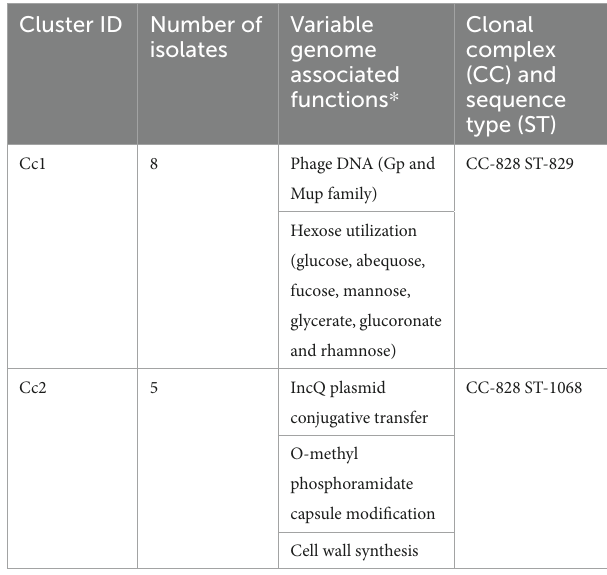
TABLE 5 Variable genome clusters in Campylobacter coli isolates.